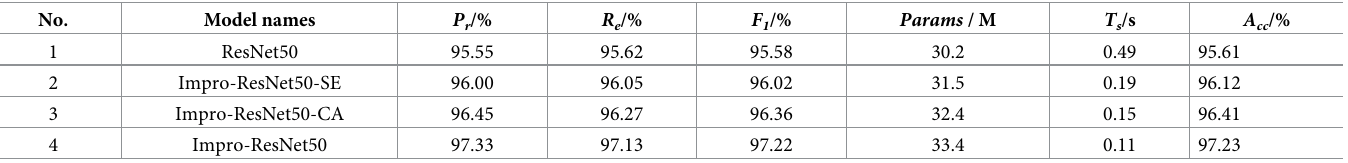
Table 3. Comparison of the results of cotton seed detection with different attention